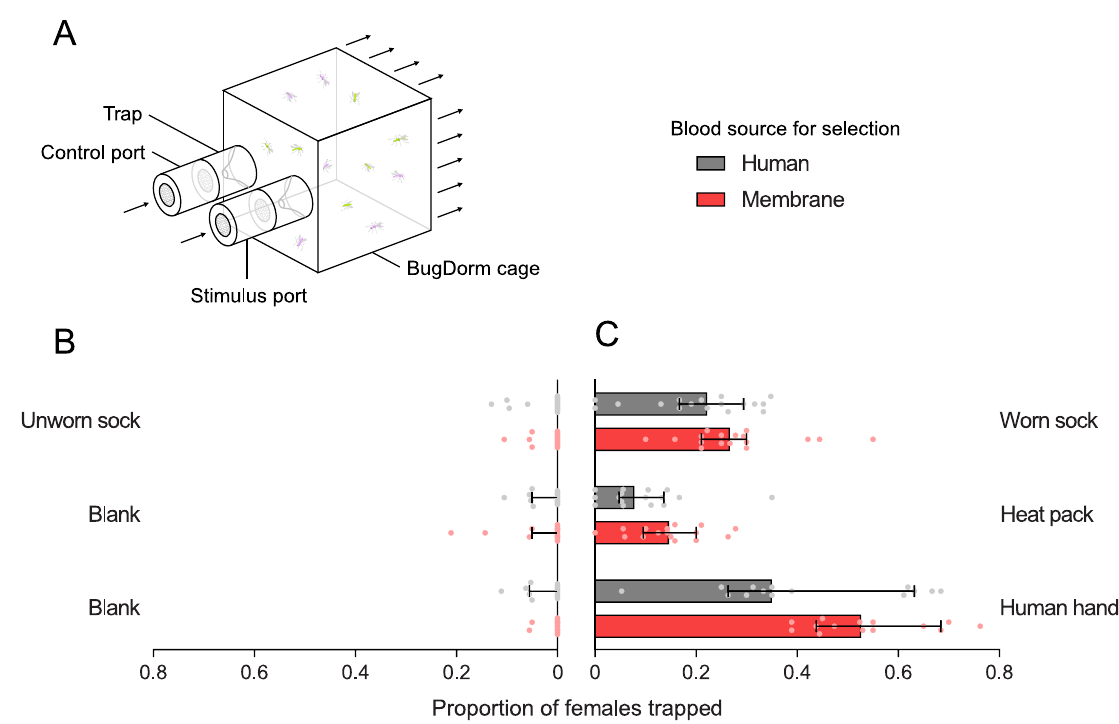
Fig 6. Attraction of female Aedes aegypti selected on human arms or membrane feeders to host cues in a two-port olfactometer. (A) Schematic of olfactometer showing the location of the stimulus and control ports (which were alternated between experiments). Arrows indicate the direction of airflow through the olfactometer. (B-C) The proportion of mosquitoes trapped in the control port (B) and stimulus port (C) for human-selected (gray) and membrane-selected (red) populations. Bars show median proportions and 95% confidence intervals while dots show proportions for individual